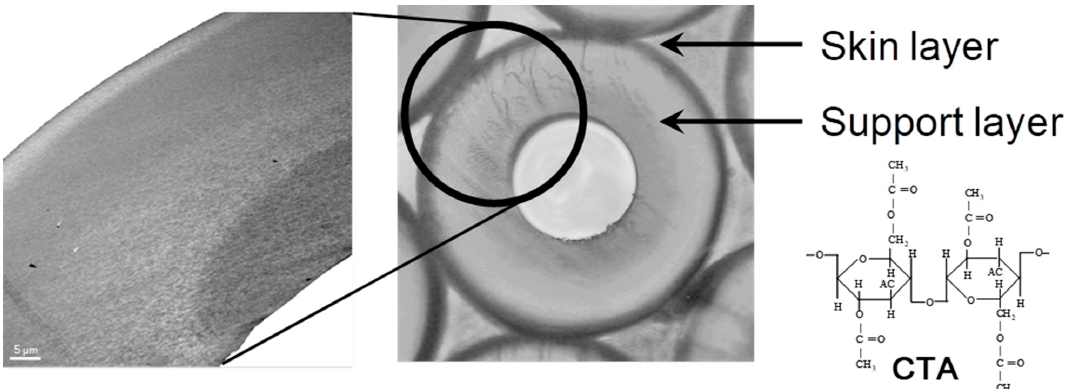
Figure 1. Typical diagram for preparation of an asymmetric membrane.